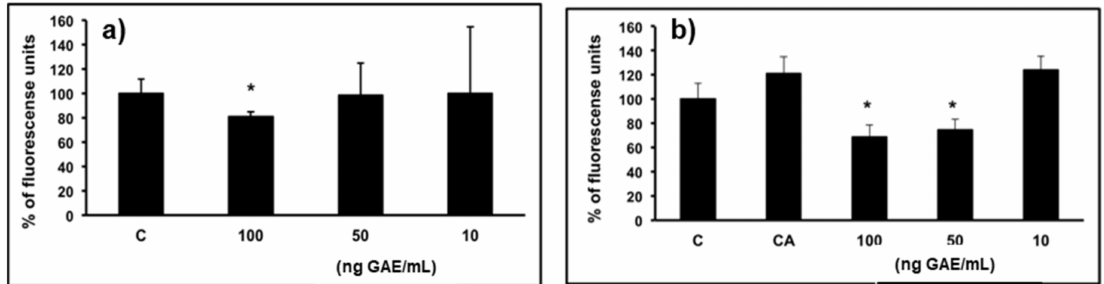
Figure 4. Protective effect of WP on intracellular ROS generation induced by t -BOOH treatment. SH-SY5Y cells were pretreated with increasing concentrations of WP (from 1 to 10 µ g/mL) corresponding to 10 to 100 ng GAE/mL. Concentrations were expressed as ng gallic acid equivalent (GAE)/mL (9.86 ng GAE/ µ g WP). Values are expressed as a percentage relative to the control conditions. ( a ) Represents basal state (0 min of t -BOOH exposure) * p < 0.05 compared to the control group. ( b ) Represents t -BOOH activation (90 min of t -BOOH exposure). * p < 0.05 compared to the control activated